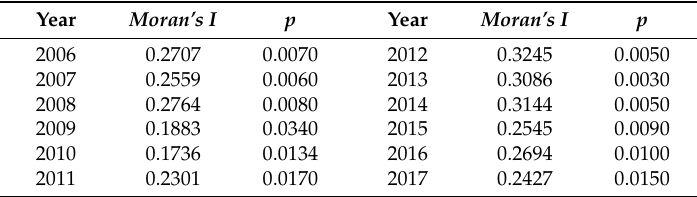
Table 5. Moran’s I for China’s Provincial EWP from 2006 to 2017.